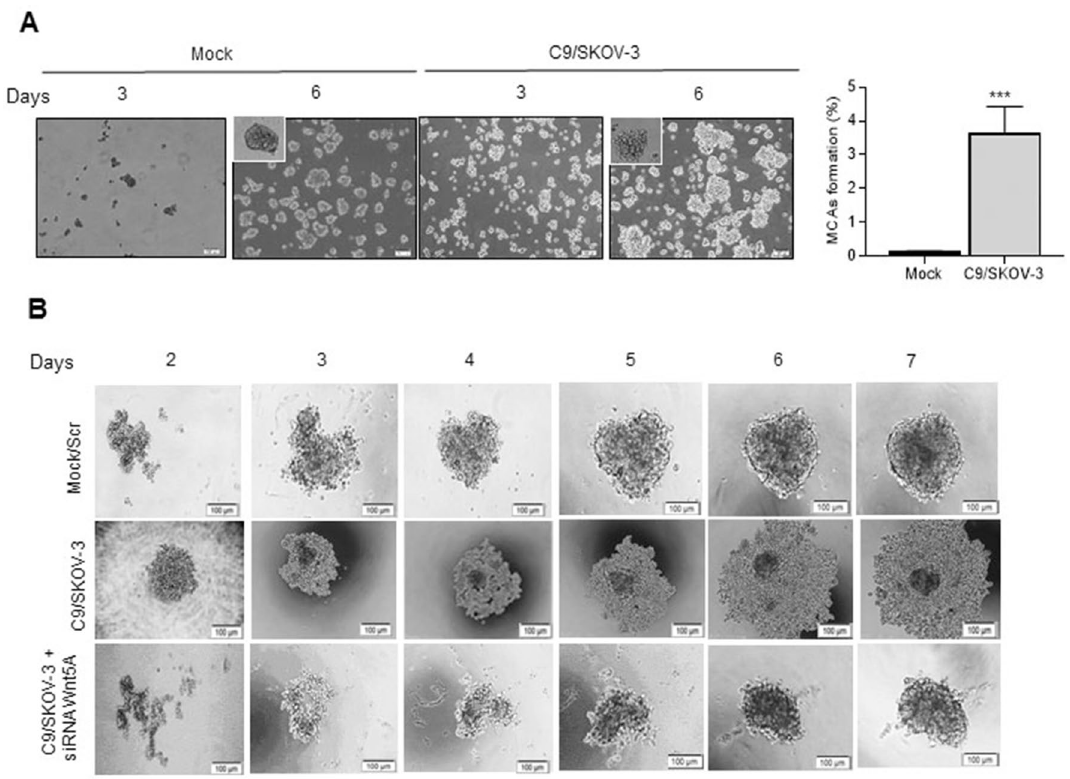
Figure 4. Wnt5A increases MCAs formation and decreases the compactness of C9/SKOV-3 MCAs. ( A ) MCAs morphology during 3 and 6 days culture (left panel). MCAs formation rate of C9/SKOV-3 clone vs. mock cells (right panel) was quantitated after 6 days in 50 µl droplet under an inverted microscope. ( B ) C9/SKOV-3 clone was transfected with siRNA against Wnt5A or scramble siRNA (25 nM) and the formation of C9/SKOV-3 MCAs was followed over 7 days. Wnt5A knockdown reverted the loose structure of MCAs formed by the C9/ SKOV-3 clone. Photos represent one of the three independently performed experiments (scale bare: 100 µm). * P < 0.05; ** P < 0.01; *** P < 0.001 compared to